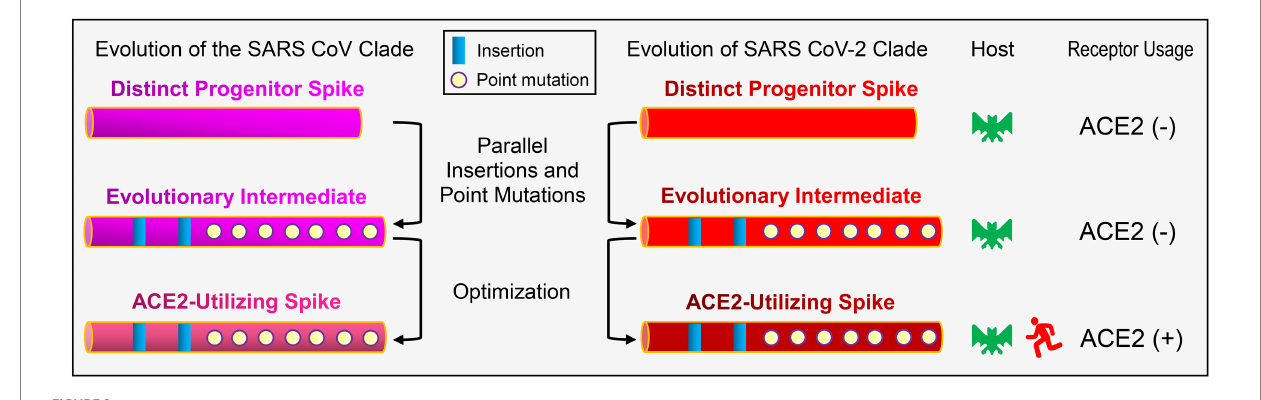
FIGURE 9 Schematic diagram of the proposed evolutionary histories of ACE2-utilizing spike proteins in sarbecoviruses. For simplicity, only RBDs are shown here. In this evolutionary scenario, two distinct progenitors are developed into SARS-CoV and SARS-CoV-2 clades via parallel insertions and point mutations followed by sequence optimization. ACE2 utilizing and non-utilizing are denoted by minus and plus signs,